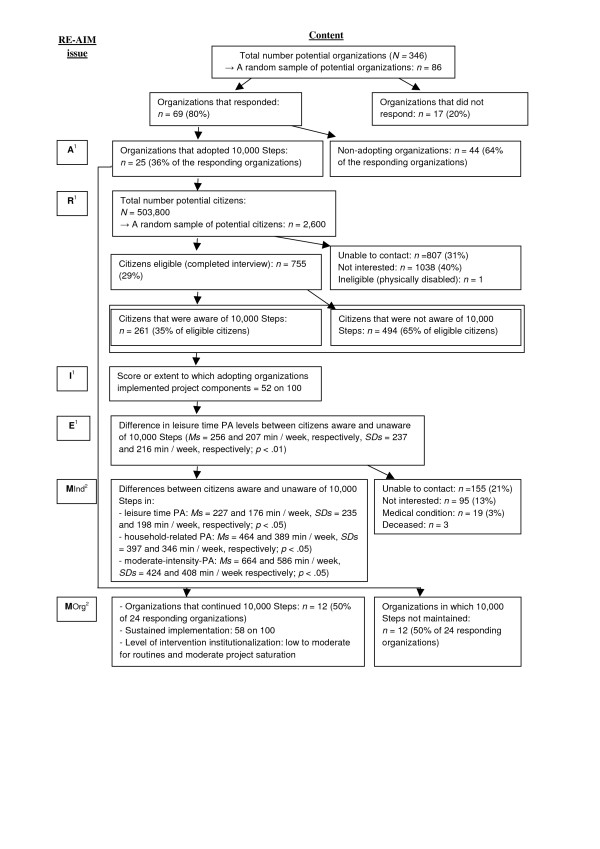
Flow chart for the different dimensions of the RE-AIM framework applied to the'10,000 Steps' project. R = Reach, E = effectiveness, A = adoption, I = implementation, Mind = maintenance at individual level, MOrg = maintenance at organizational level. 1 Results of the initial evaluation with the RE-AIM framework [15]. 2 Results of the current sustainability study.